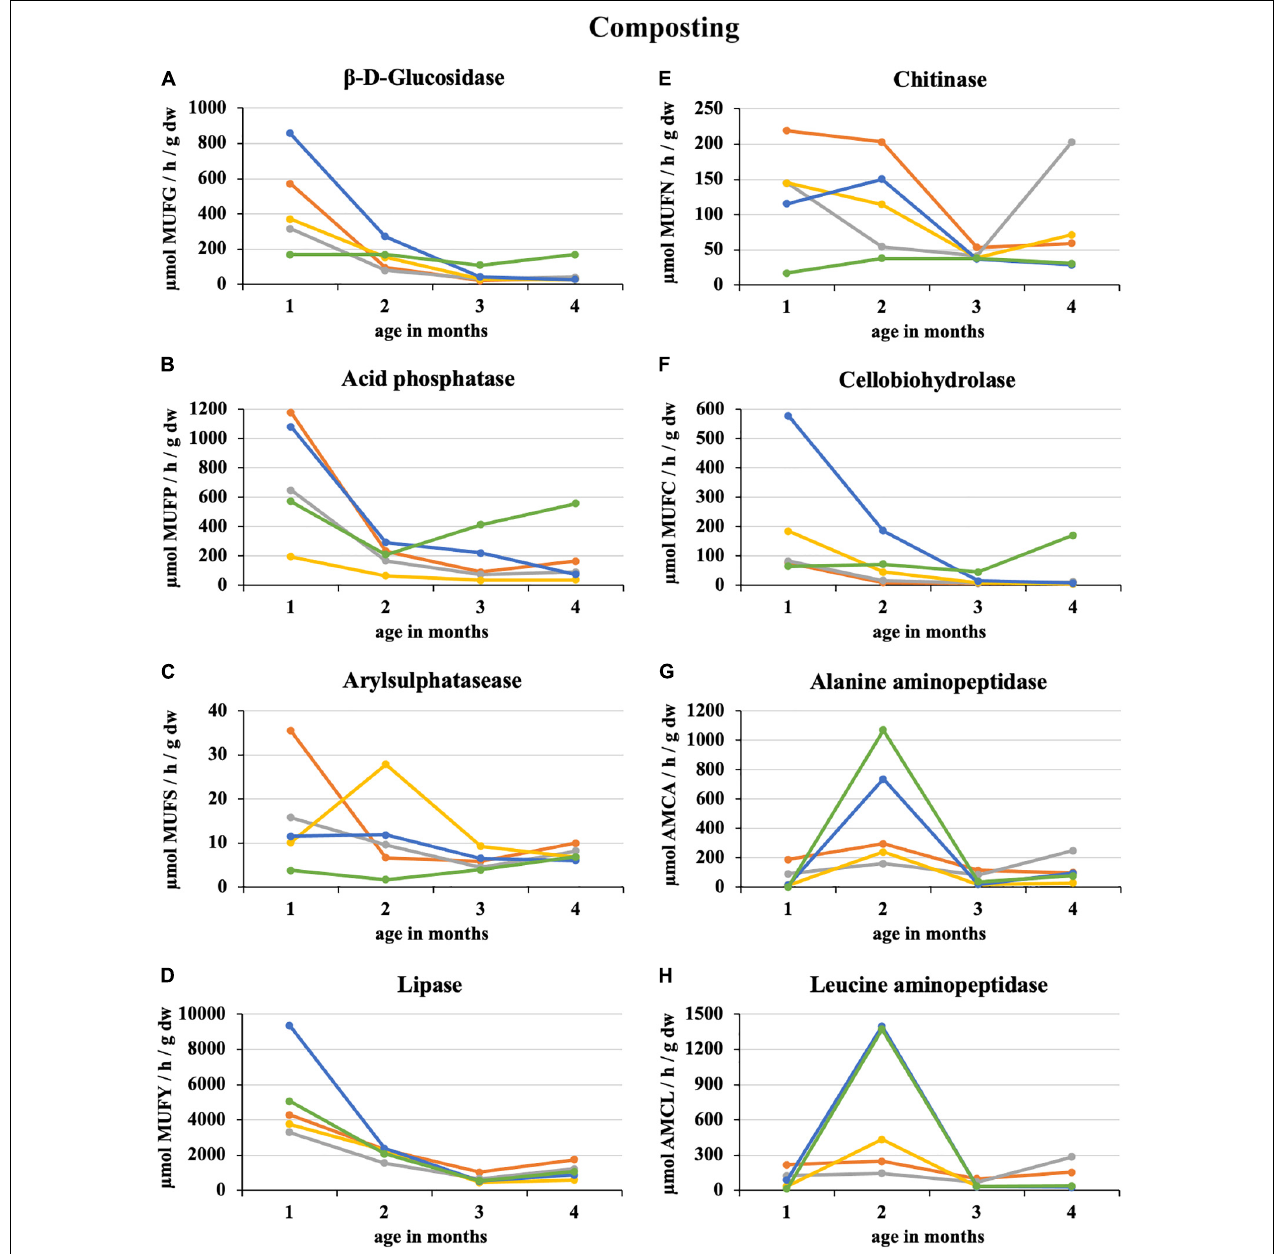
FIGURE 1 | Course of enzymatic activity during composting of fresh feedstock. , sludge 100%; , sludge 75% + PWS 25%; , sludge 50% + PWS 50%; , sludge 25% + PWS 75%, , PWS 100%; PWS, pelletized wheat straw; dw, dry weight; MUFG, 4-methylumbellyferyl- β -D-glucopyranoside; MUFP, 4-methylumbellyferyl-phosphate; MUFS, 4-methylumbellyferyl sulfate potassium salt; MUFY, 4-methylumbellyferyl-caprylate;